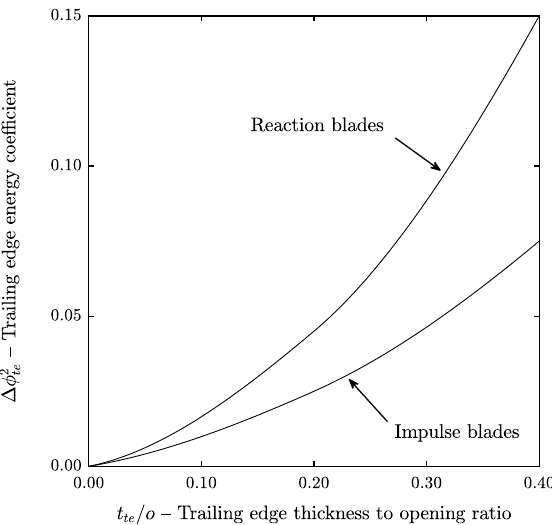
Figure A4. Trailing edge energy loss coefficient for impulse and reaction